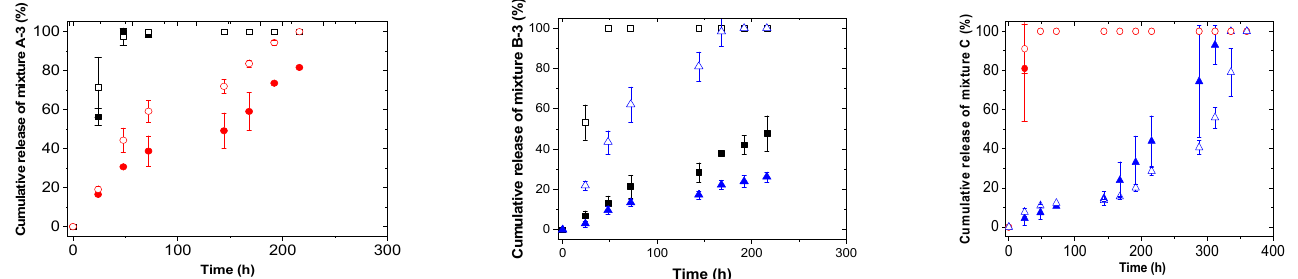
Figure 1. Release kinetics as a function of pH for different mixtures at 25 ◦ C. (cid:4) DBBH at pH 6, (cid:3) DBBH at pH 4.4, • Figure 1 . Release kinetics as a function of pH for different mixtures at 25 °C. ■ DBBH at pH 6, □ DBBH at pH 4.4, ● Benzophenone-4 at pH Benzophenone-4 at pH 6, ○ Benzophenone at pH 4.4, ▲ Salicylic acid at pH 6, Δ Salicylic acid at pH 4.4.